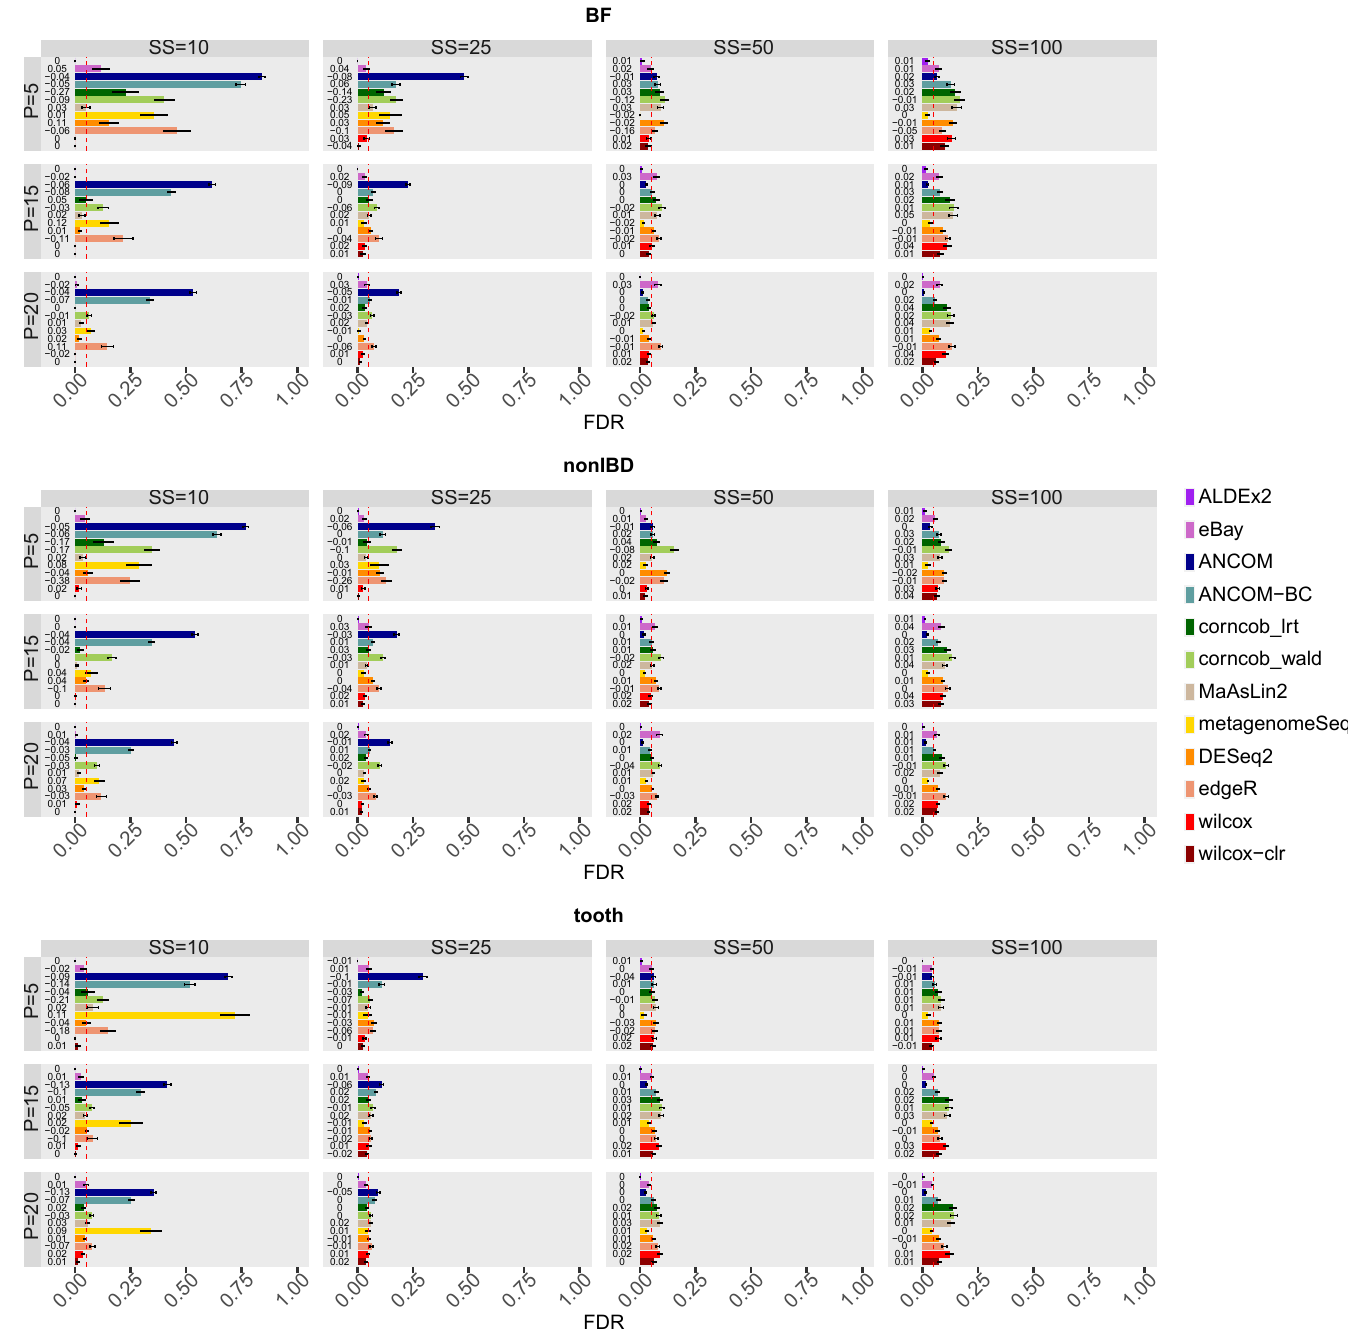
Fig 8. FDR of each differential abundance method for each dataset considered in the comparison in simulations with reduced variability. In each set of boxes corresponding to the dataset, different percentages (P) of simulated DA features are on rows, while different sample size (SS) values are on columns. The FDR values are averaged over the 50 simulations and the bars show the standard error. The difference in the mean FDR between the scenario with reduced variability and the main scenario with simulated DA features is shown at the beginning of the